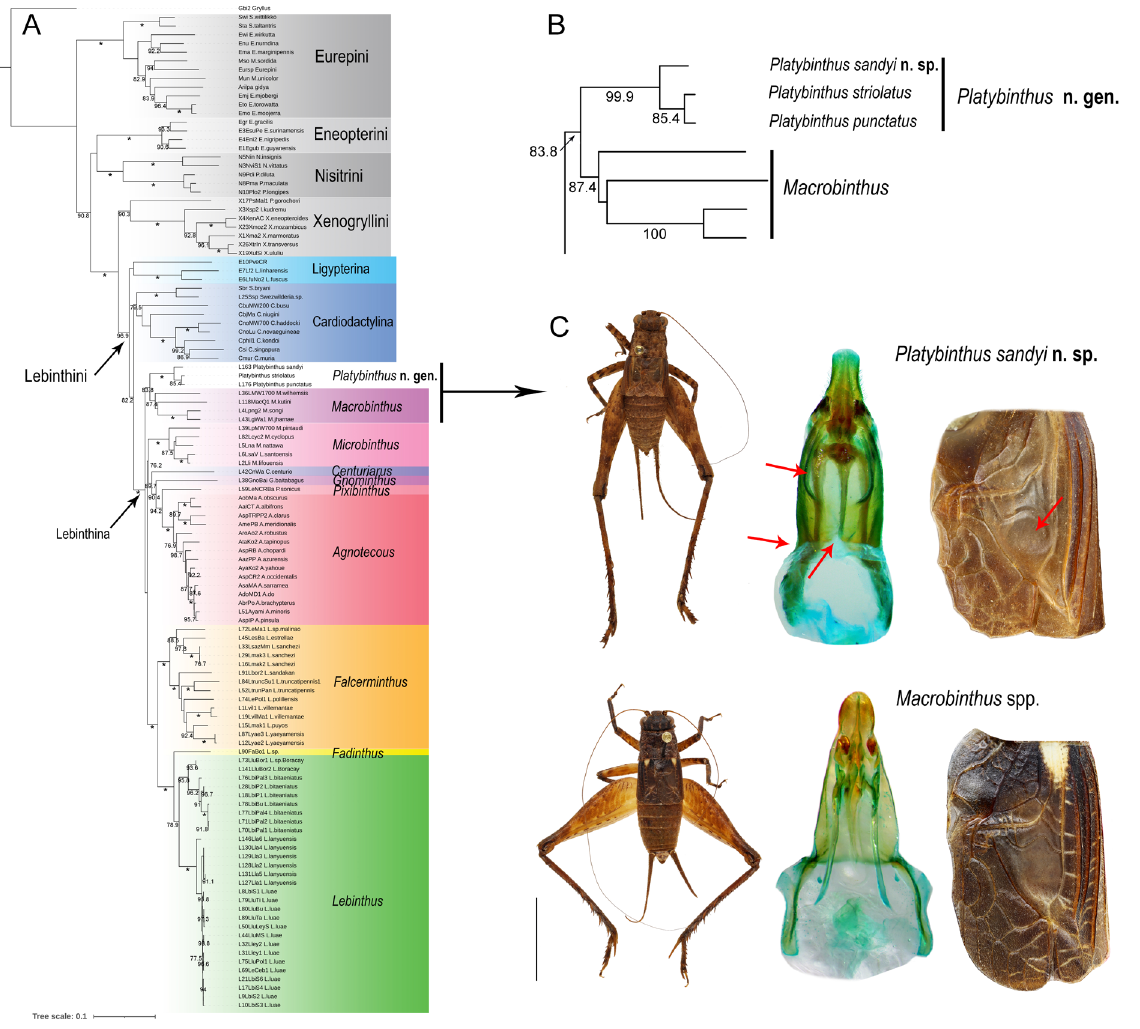
Fig. 3. A . Maximum likelihood phylogenetic tree based on concatenated sequences of eight molecular markers. Values under branches indicate bootstrap values; bootstrap value > 99 is indicated with an asterisk (*). B . Close-up view of the maximum likelihood phylogenetic tree showing the relationships among species of Platybinthus gen. nov. and with Macrobinthus Robillard & Dong, 2016. C . Morphological comparison of the males (habitus, genitalia and FW) between Platybinthus and Macrobinthus . The red arrows indicate diagnostic characters for Platybinthus . Scale bar (for habitus) = 10